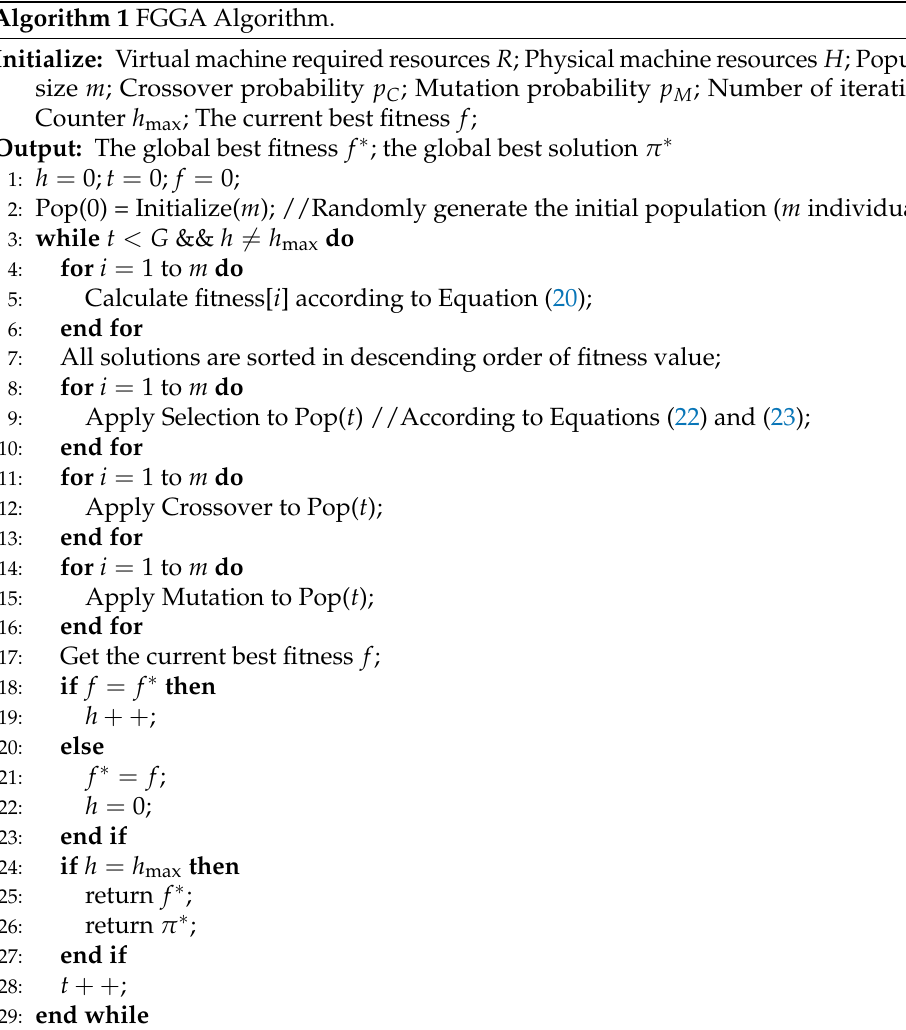
Algorithm 1 FGGA